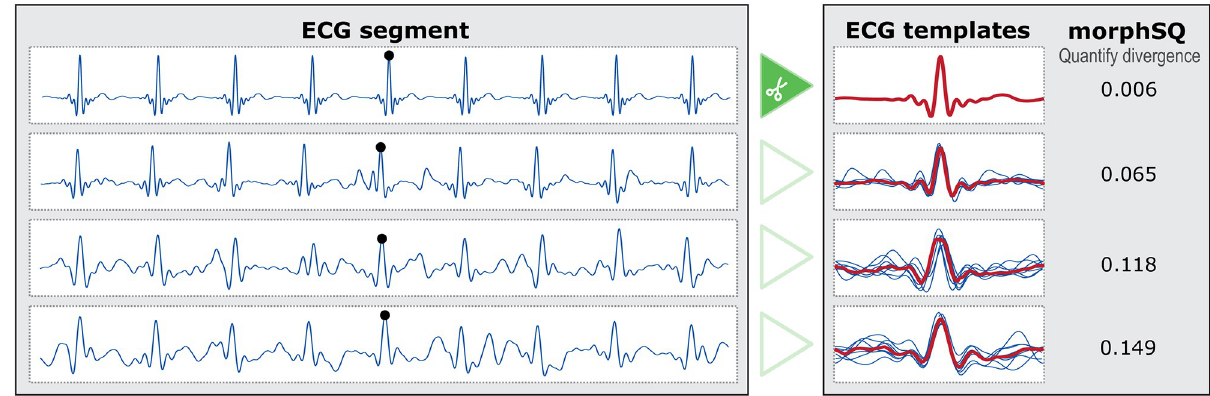
Fig 3. Examples of ECG segments with different signal quality measured by quantifying the similarity of ECG templates. Very clean segments have a morphSQ near to zero, noisy segments have values larger than 0.1.